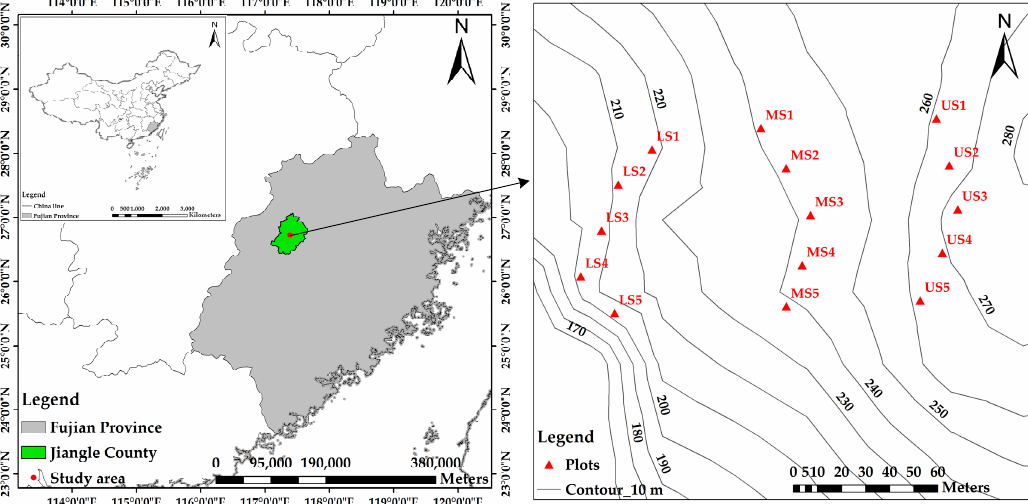
Figure 1. Location of study area and plot distribution.